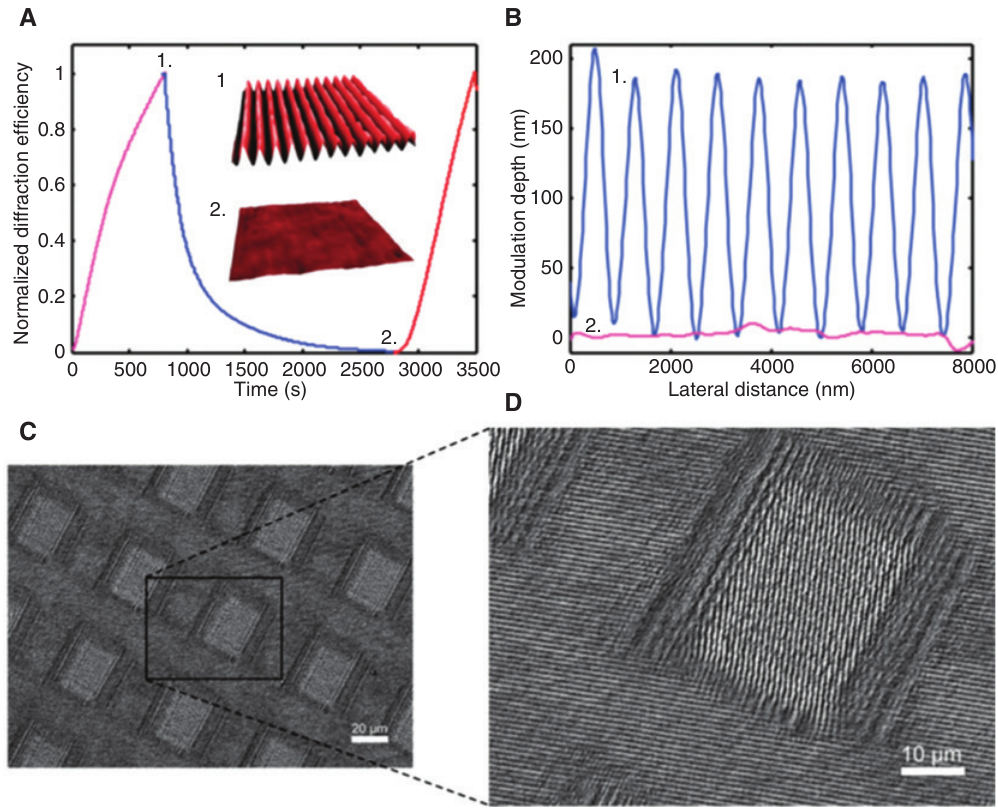
Figure 11: Erasure and rewriting of SRGs in different directions. (A) Normalized first-order diffraction efficiency relative to one-dimensional SRG inscription (magenta), optical erasure (blue) and rewriting (red) processes in a supramolecular azomaterial. The inset shows 3D AFM images of the inscribed (1) and the erased film (2), while their topographic profiles are presented in panel (B) by the blue and magenta curves, respectively. (C–D) Scanning electron microscopy images of the spatially structured azomaterial surface created by first optically erasing a previously inscribed SRG through a transmission mask and then rewriting a new SRG pattern through the same mask. Reproduced from Ref. [76] with permission from the Royal Society of